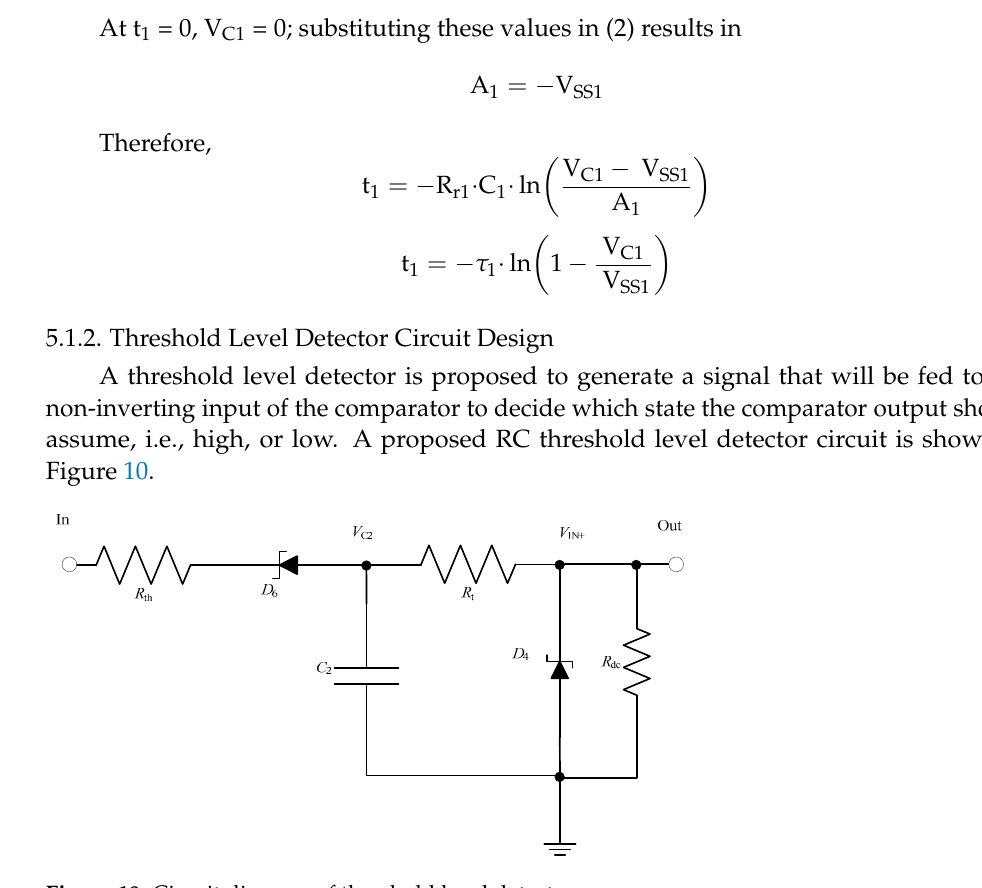
Figure 10. Circuit diagram of threshold level